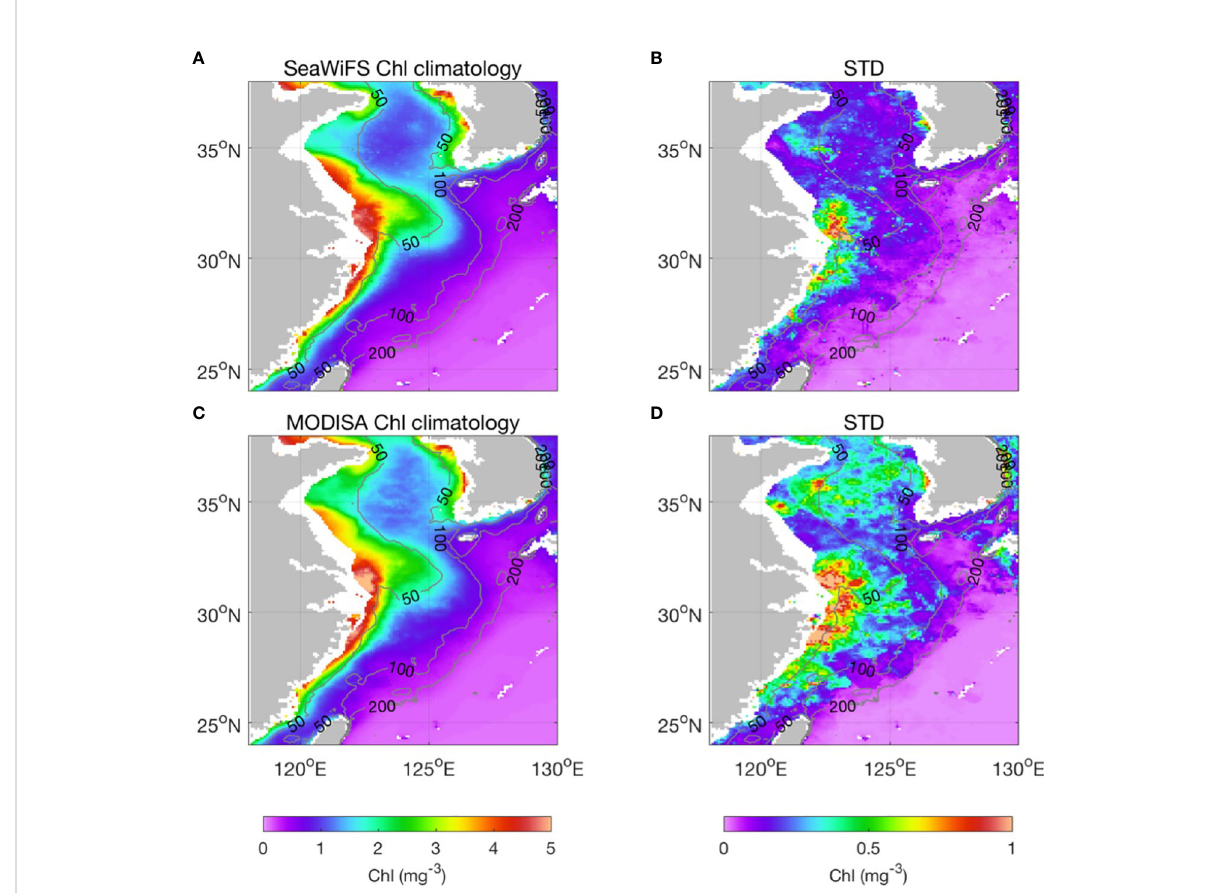
FIGURE 4 Climatology distributions of the mean (left column) and standard deviation (right column) of Chl-a for SeaWiFS (1998 – 2007, upper panel A, B ) and MODISA (2003 – 2019, bottom panel C, D ). The gray contour lines in each map denote the 50-, 100-, and 200-m